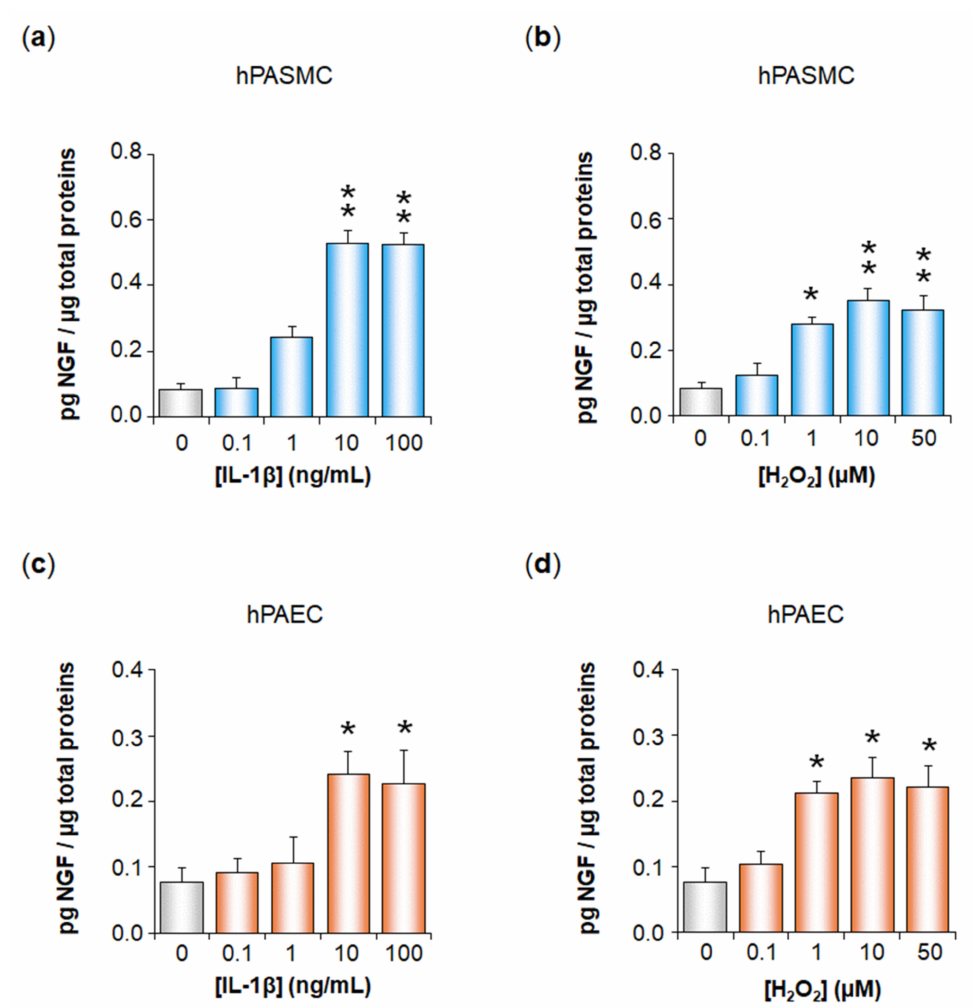
Figure 1. NGF secretion by human pulmonary arterial cells after treatment with IL-1 β or H 2 O 2. NGF secretion by human pulmonary arterial smooth muscle cells (hPASMC, ( a , b )) or by human pulmonary arterial endothelial cells (hPAEC, ( c , d )) was assessed in the absence or presence of interleukin-1 β (IL-1 β , 0.1–100 ng/mL, 24 h, ( a , c )) or hydrogen peroxide (H 2 O 2 , 0–50 µ M, 24 h, ( b , d )). NGF secretion was determined by ELISA (results expressed as pg NGF/ µ g total proteins). The data represent the means ± SEM of n = 5 independent experiments performed in triplicate on cells from three to five control donors. *: p < 0.05 and **: p < 0.01 versus untreated control cells. NGF secretion by hPASMC was also significantly increased after cell treatment with H 2 O 2 , with a maximal increase at 10 µ M (from 0.09 ± 0.02 to 0.35 ± 0.04 pg NGF/ µ g total proteins, p < 0.01, Figure 1b). Similar results were observed in hPAEC, with NGF